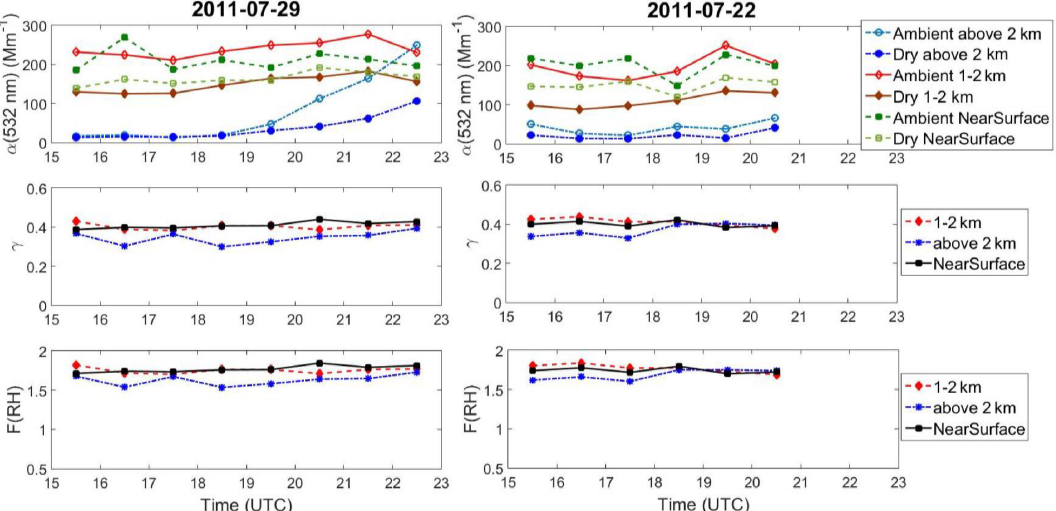
Figure 11. Hourly mean values of aerosol extinction at 532nm ( α (532nm)) and hygroscopicity parameters γ and f (RH) for both 29 and 22 July. Data are presented for three different altitudes: near the surface (altitude below 1km), in the planetary boundary layer (1–2km for 29 July and 1–1.8km for 22 July) and above the planetary boundary layer ( > 2 . 0km for 29 July and > 1 . 8km for 22 July).